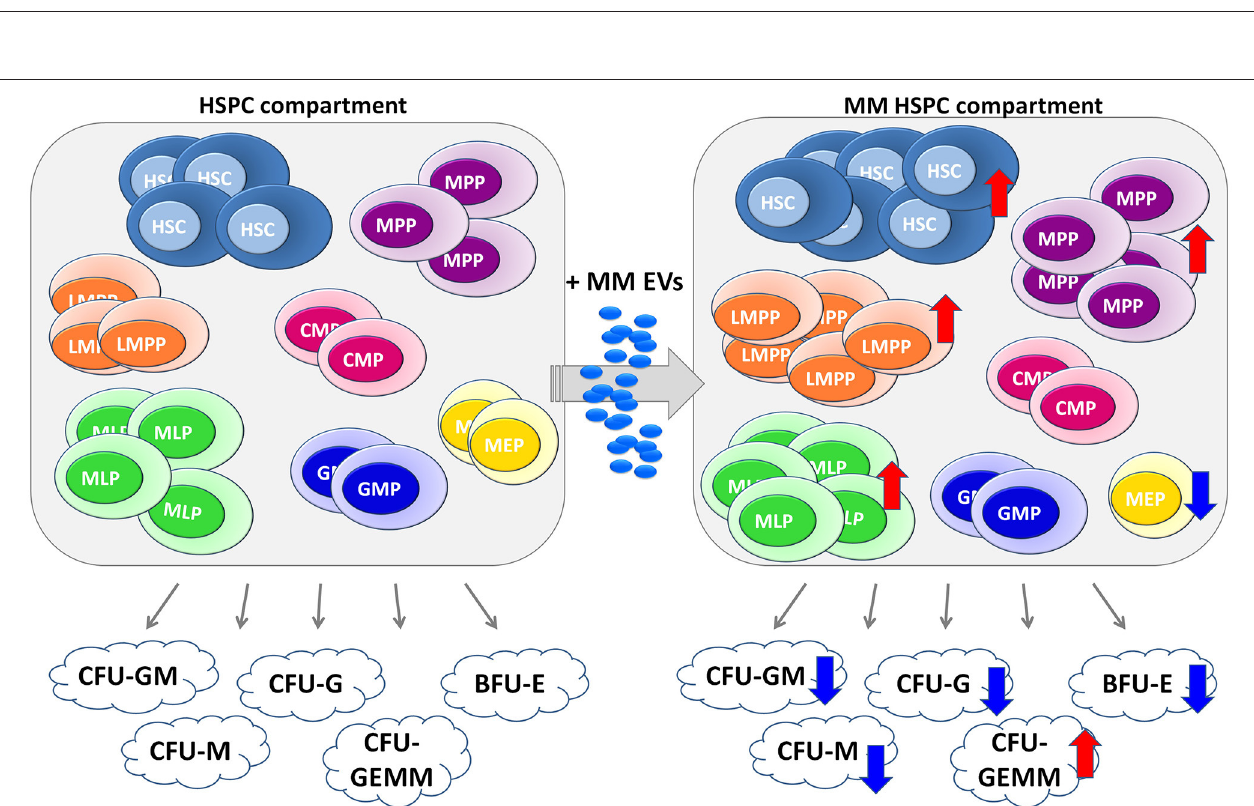
FIGURE 7 | Cartoon of MM-EV action in HSPC compartment. The healthy HSPC compartment is characterized by different populations, such as hematopoietic stem cells (HSCs), multipotent progenitors (MPP), lymphoid-primed multipotent progenitor (LMPP), multi-lymphoid progenitor (MLP), common myeloid progenitor (CMP), megakaryocyte erythroid progenitor (MEP), granulocyte macrophage progenitor (GMP), and B/NK progenitors (B/NK prog). These progenitors are able to generate different colonies, such as CFU-Granulocyte, Macrophage (CFU-GM), CFU Macrophage (CFU-M), CFU Granulocyte (CFU-G), CFU Granulocyte, Erythrocyte, Macrophage, Megakaryocyte (CFU-GEMM), and Burst-Forming-Unit Erythrocyte (BFU-E, on the left). On the right, the EVs released by MM cells are captured by HSPCs, which in the response block their differentiation with consequent impairment of the ability to form colonies. The arrows indicate an increase ( ↑ ) or a decrease ( ↓ ) induced by MM-EVs on both different HSPC populations and colonies. MM, multiple myeloma; EVs, Extracellular vesicles; HSPC, hematopoietic stem and progenitor cells.